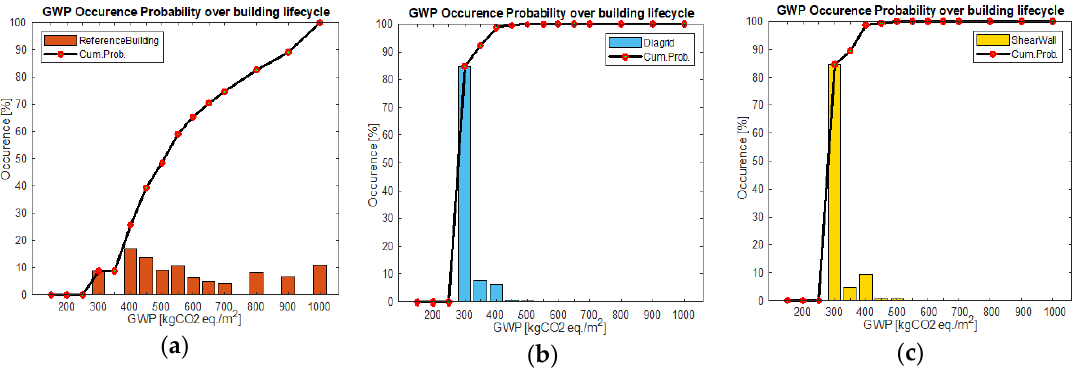
Figure 7. GWP occurrence probability for ( a ) not-retrofitted reference building, retrofitted building with ( b ) diagrid and ( c ) shear walls.